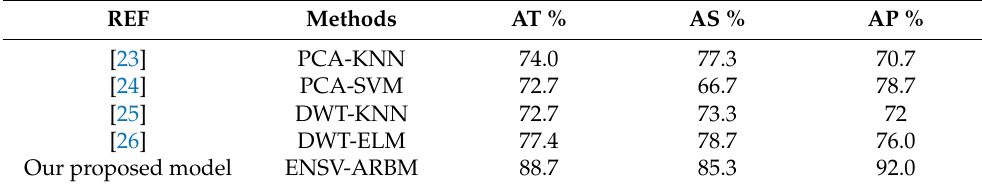
Table 2. Comparison of the results of the proposed scheme with other tactile